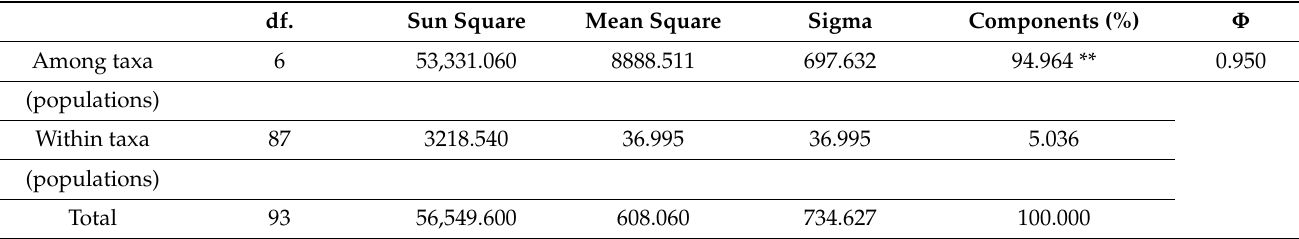
Table 4. AMOVA of the test samples and the variance components.